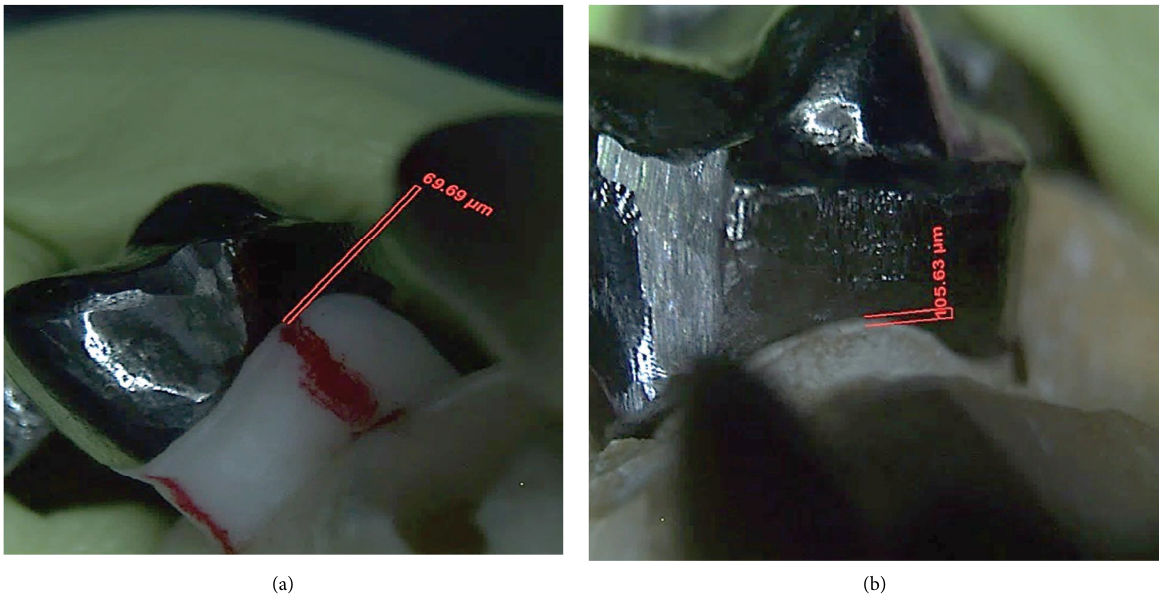
Figure 2: Te vertical marginal misft was evaluated using a light microscope at × 10 magnifcation under a direct LED lamp in the midbuccal, midmesial, and midlingual around the second premolar abutment. (a) Te vertical misft calculation in the mesial surface of second premolar on the original model. (b) Te vertical misft calculation in the mesial surface of second premolar on the cast model for the two-step putty/light-body